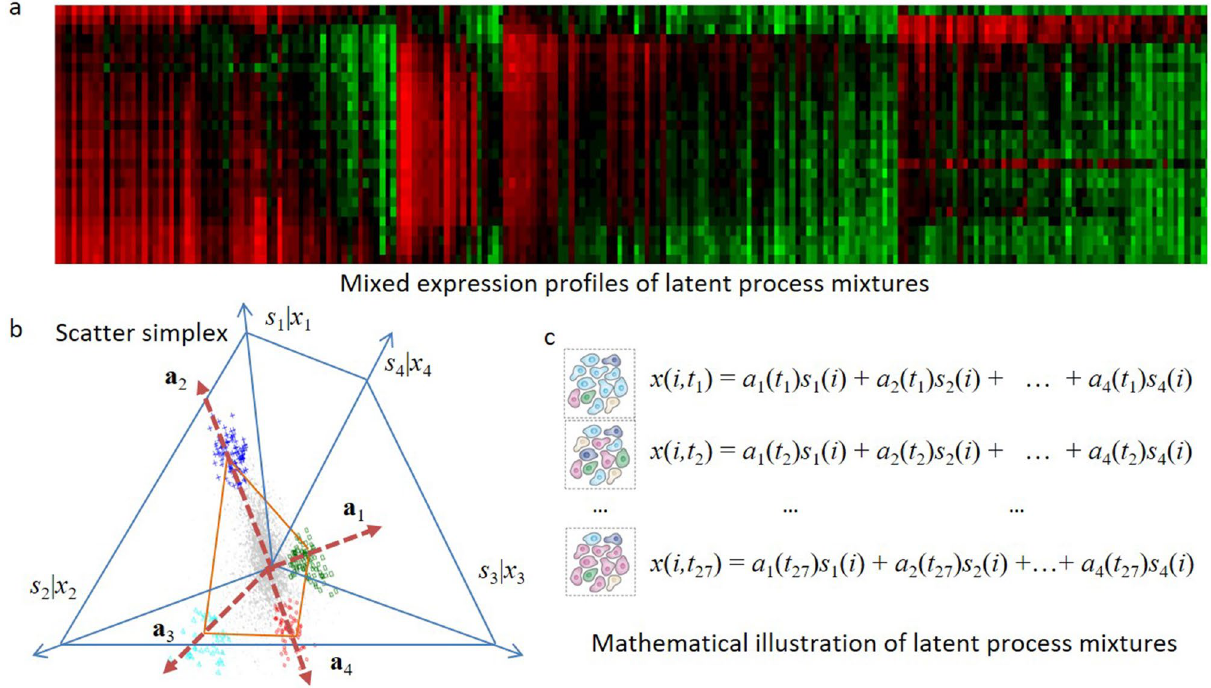
Figure 6. CAM principles for latent variable modelling and deconvolution. ( a ) Mixed expression profile of latent process mixtures. ( b ) Illustration of mixing operation in scatter space, where a compressed and rotated scatter simplex whose vertices host marker genes is produced and corresponded to mixing proportions. ( c ) Mathematical description of expression profile of latent process